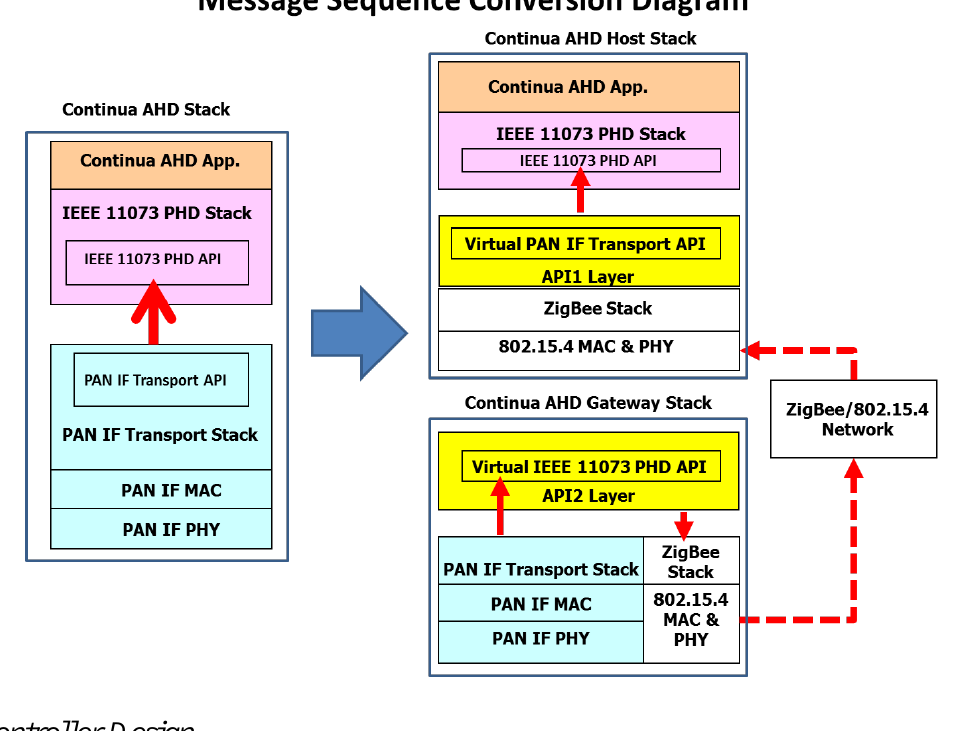
Figure 4. Message sequence conversion from PAN IF Transport Stack to IEEE 11073 PHD